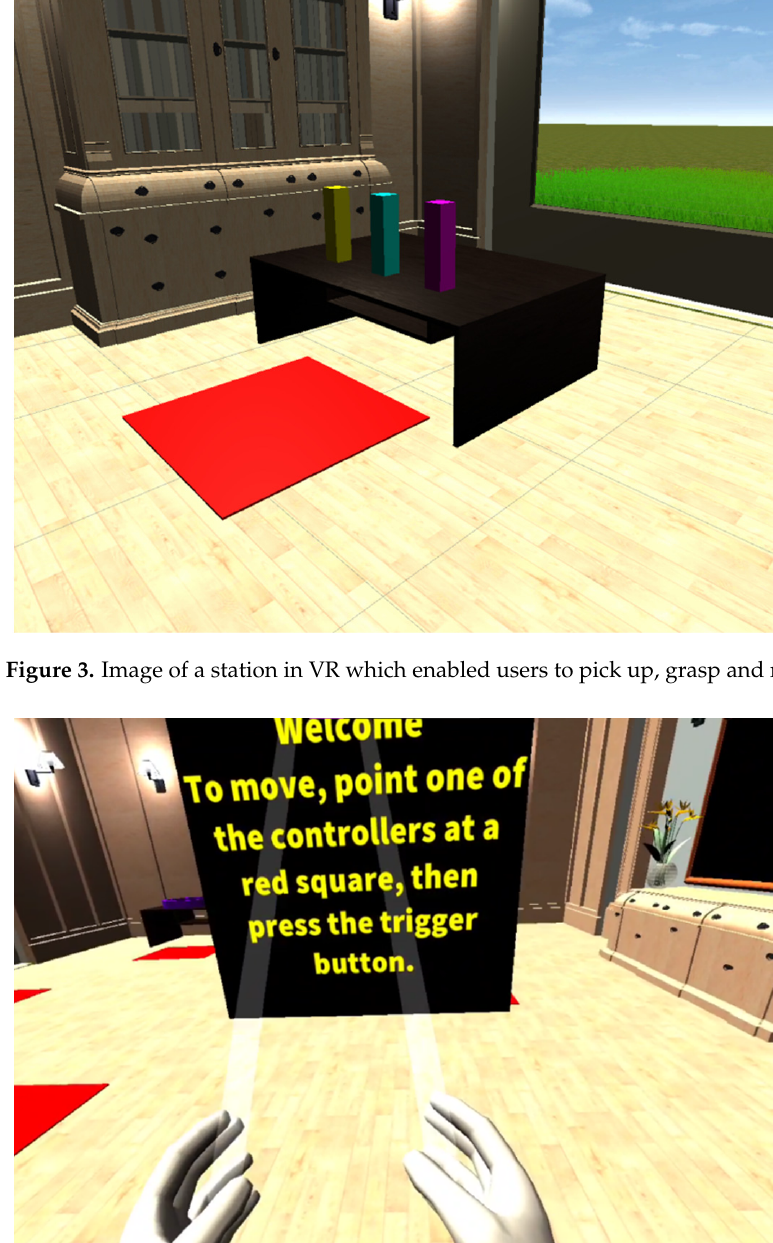
Figure 3. Image of a station in VR which enabled users to pick up, grasp and move blocks.